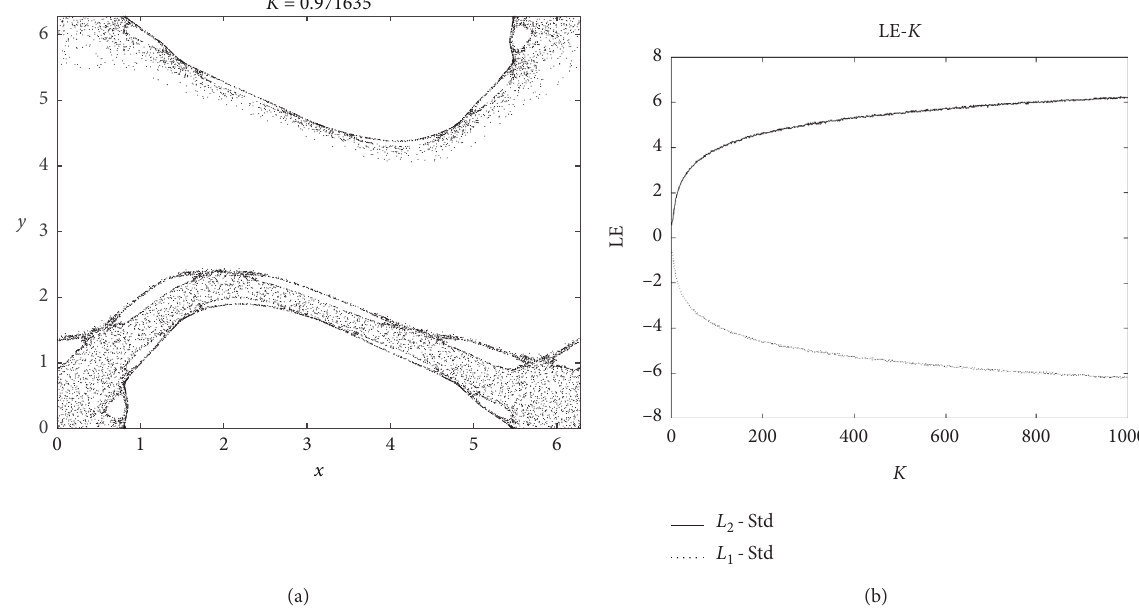
Figure 3: The standard map analysis: (a) the phase space of the standard map at K � 0 . 971635; (b) the Lyapunov exponent curves of the standard map with variation of parameters.